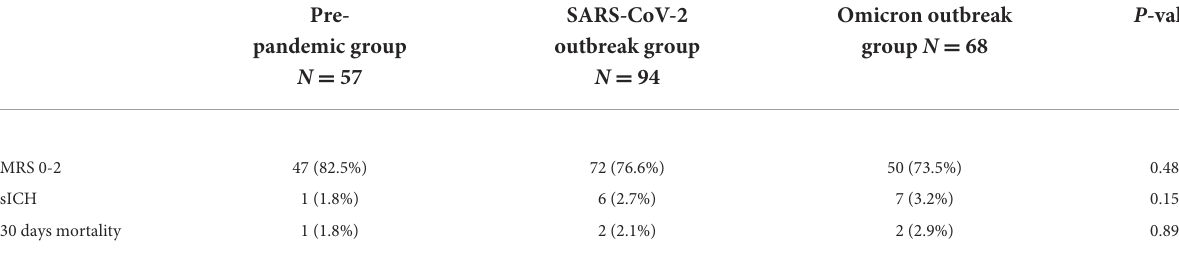
TABLE 4 Comparisons of outcome indicators in the three groups of patients undergoing intravenous